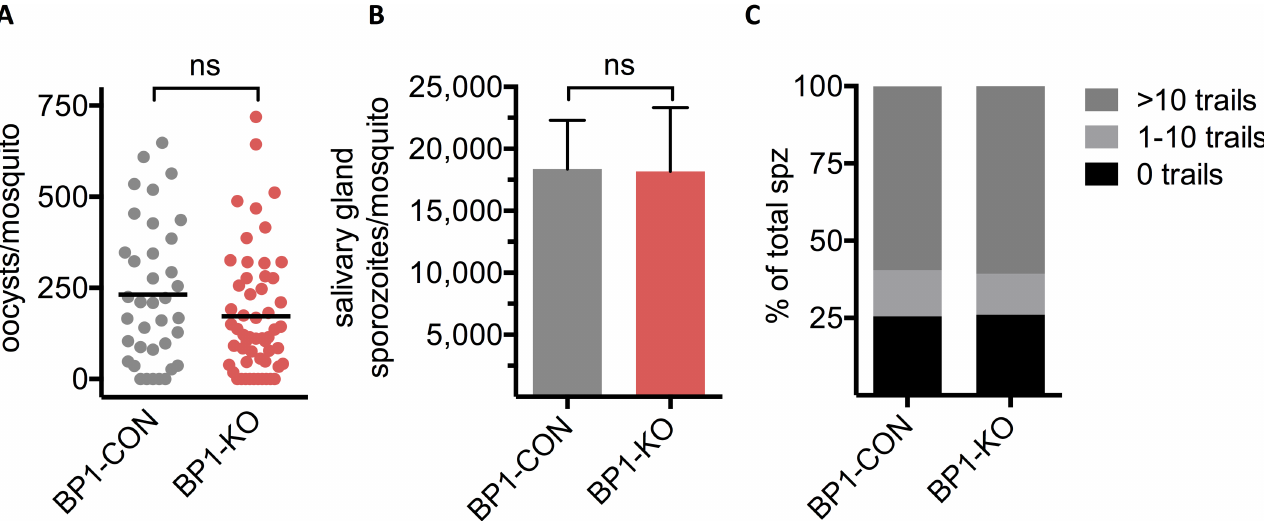
Fig 1. Berghepain-1 knockout parasitesdevelop normally in the mosquito and sporozoites are motile. A. Oocyst formation. Midguts were dissected 13 days after the infectiousblood meal and GFP-positive oocysts were counted. Horizontallines represent mean values. Shownare pooledresults from two independent experiments using BP1-CON and BP1-KO clone 1, and one experiment using BP1-CON and BP1-KO clone 2. B. Salivary gland sporozoite numbers. Salivaryglands were isolated from 20 mosquitoes,19 days after the infectiousbloodmeal, and sporozoites were counted. Shown are the mean and standarddeviationof sporozoitenumbers per mosquito, obtainedfrom four independent experiments using BP1-CON and BP1-KO clone 1, and one experiment using BP1-CON and BP1-KO clone 2. C. Gliding motility . BP1-CON and BP1-KO sporozoites were allowedto glide for 1 h at 37˚C on coated glass coverslipsand trails were visualizedby detection of shed surface protein CSP. A total number of 2181 BP1-CON and 3189 BP1-KO sporozoites with and without trails were counted and the percent of sporozoites associated with the indicatednumberof circular trails is shown. Both clones of BP1-KO parasites were analyzedand results were pooled.